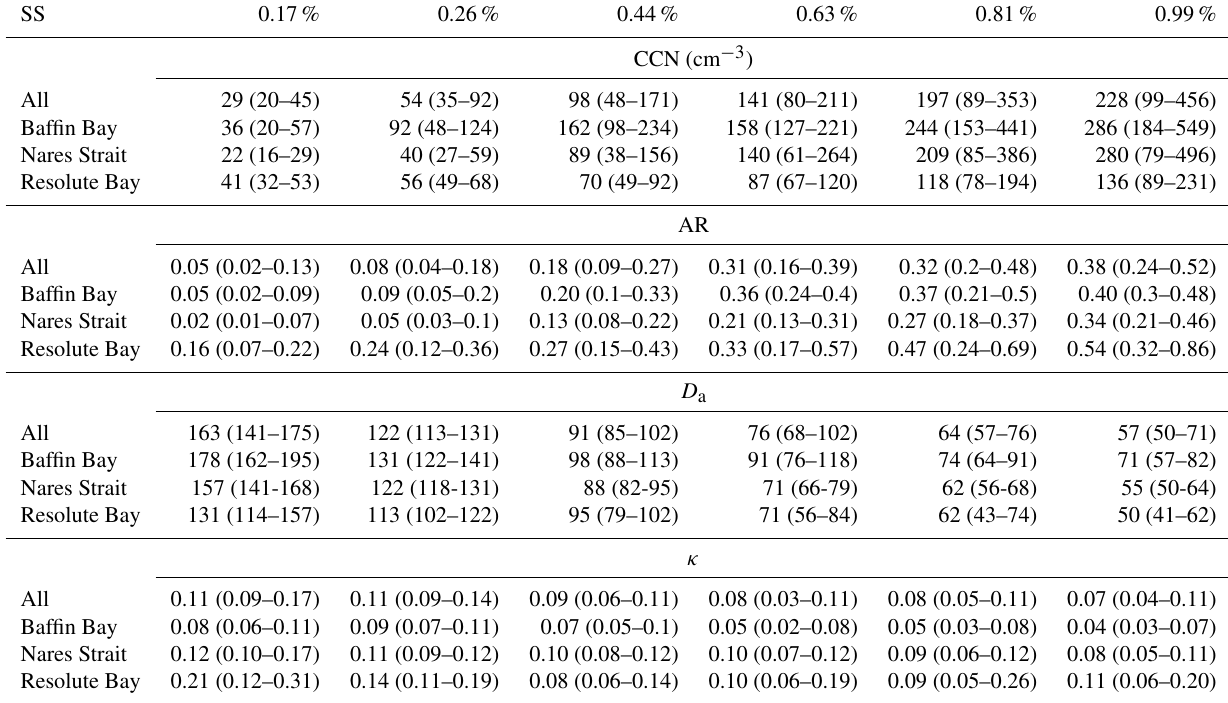
Table 1. Summary of CCN concentrations and associated calculations, given as median (25th–75th percentile).